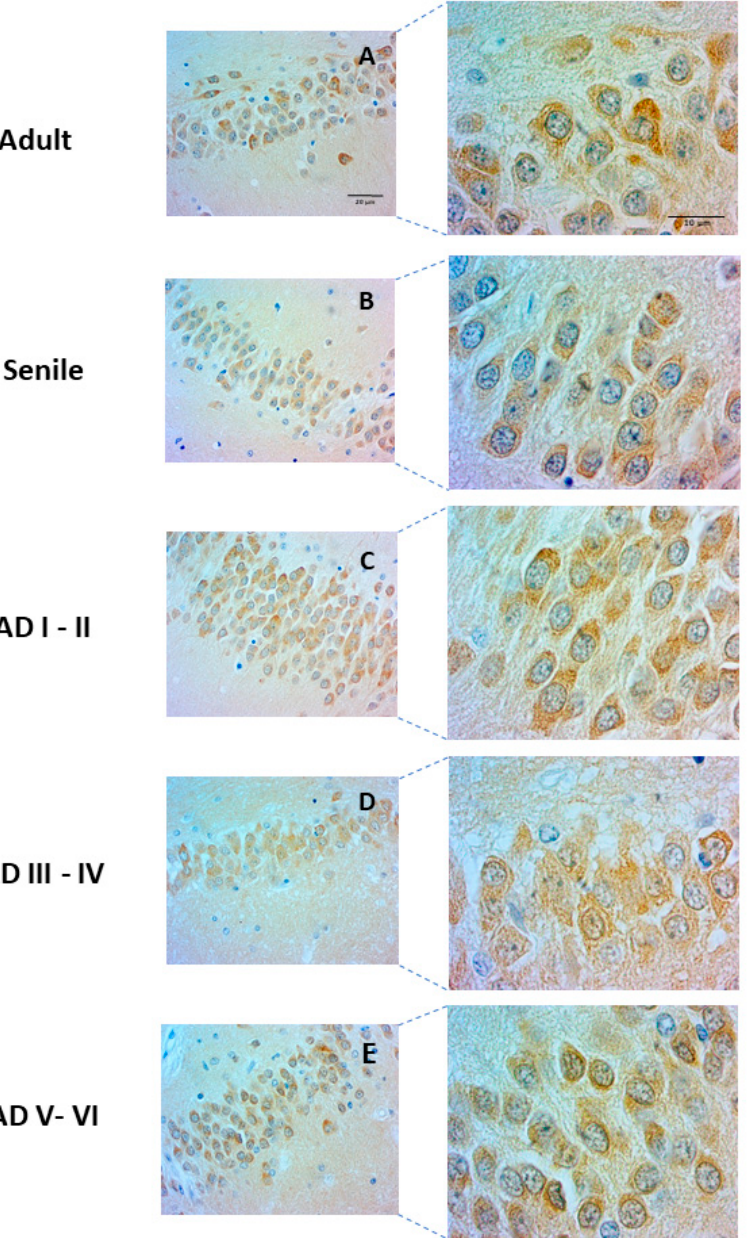
Figure 5. Increased nucleophagy in intermediate and late AD stages. Transition from predominantly cytoplasmic ( A – C ) to nuclear and perinuclear LC3 immunopositivity ( D , E ). Scale bar: 20 µ m. Right panels show higher magnification of the nuclear LC3 autophagy marker, noticeable in intermediate and late AD stages. Scale bar: 10 µ